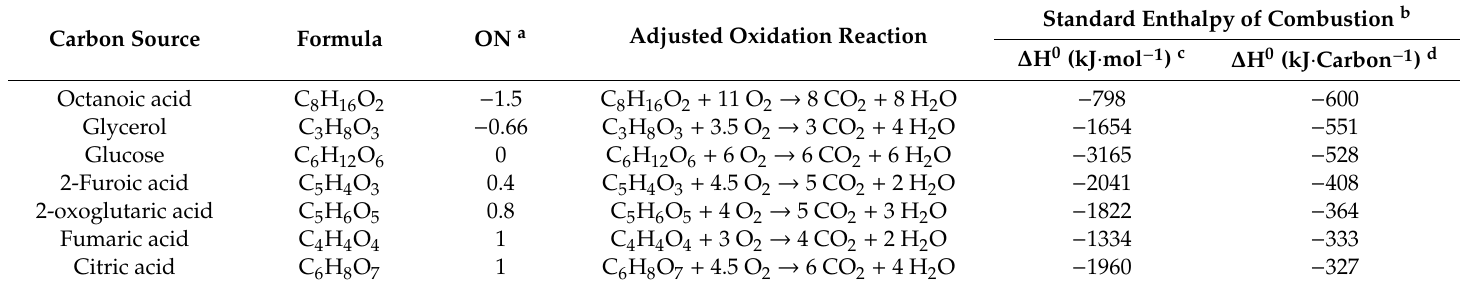
Table 1. Properties of the chemical compounds used as carbon sources in the present